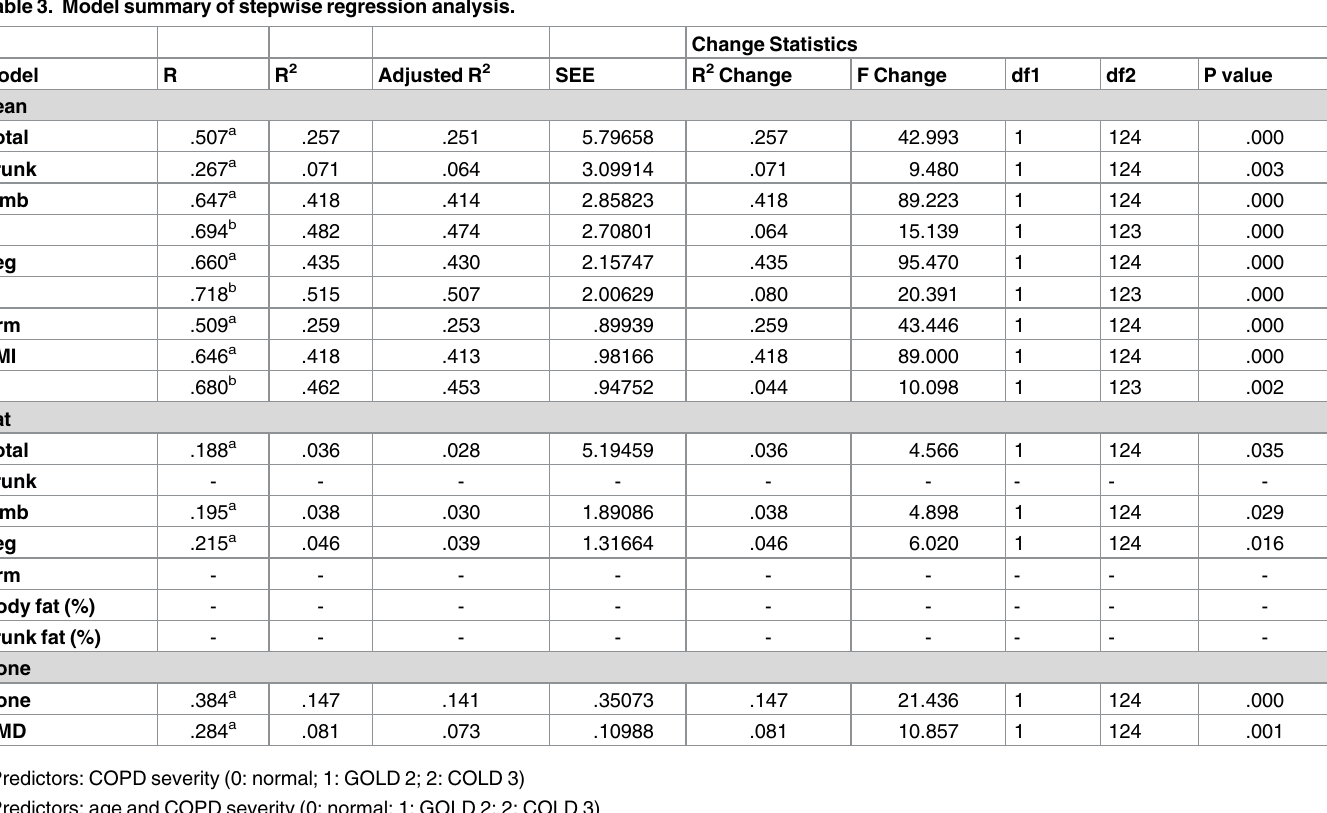
Table 3. Model summaryof stepwise regression